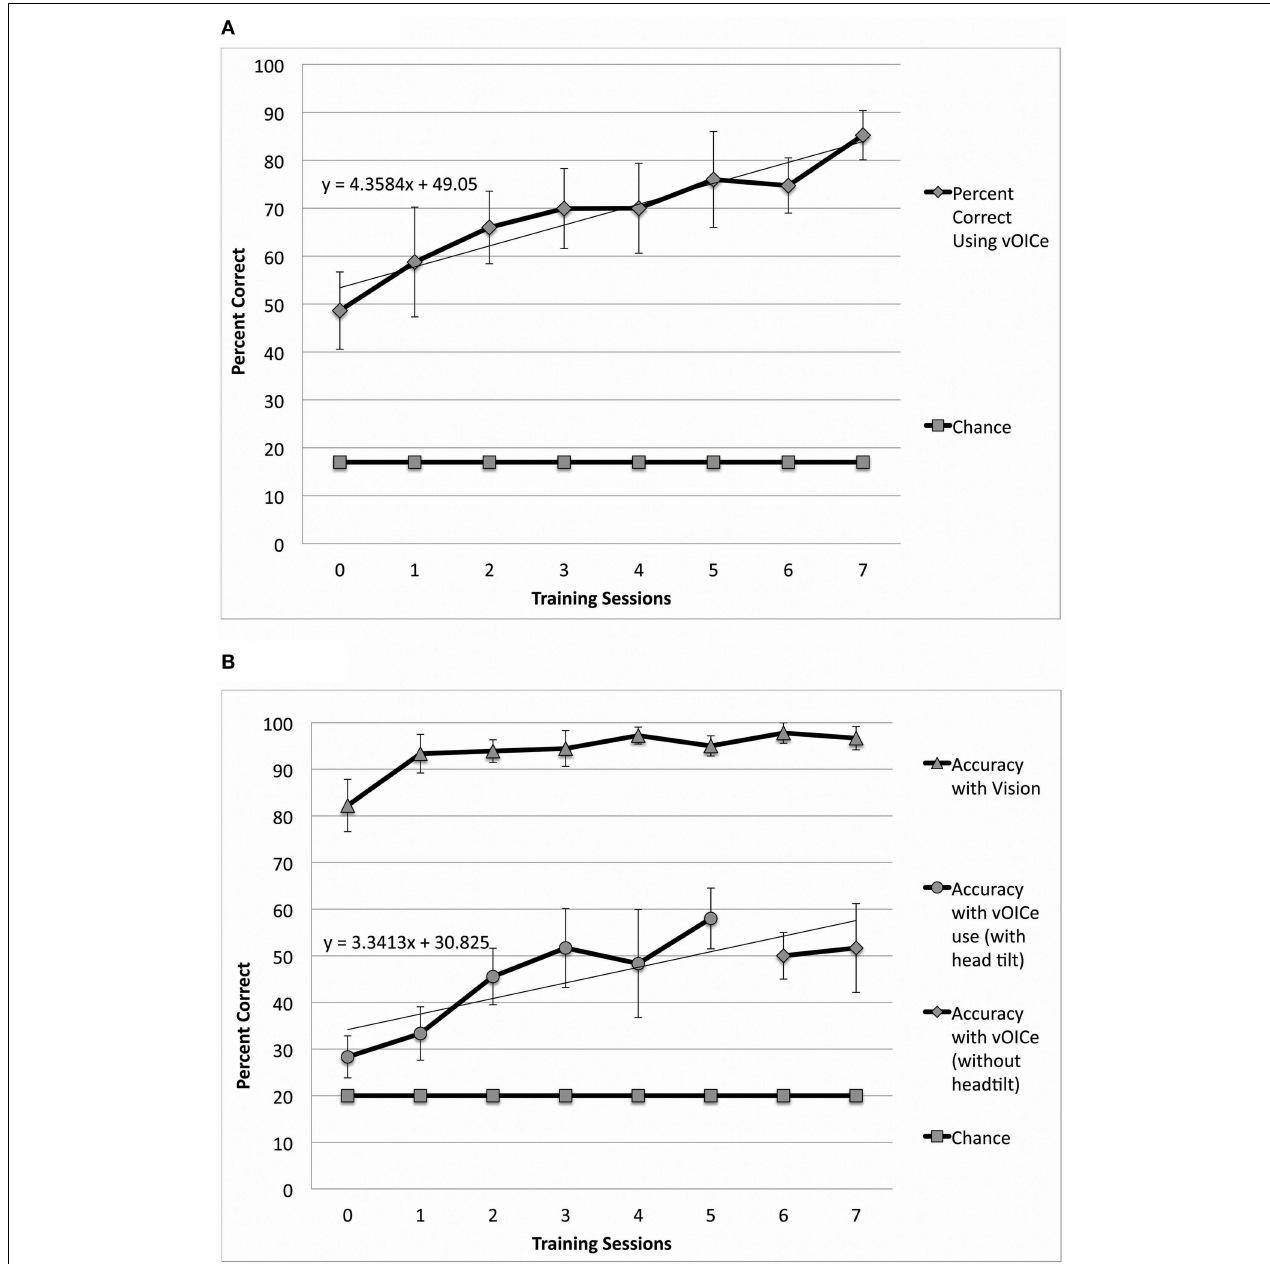
FIGURE 2 | Performance in both constancy tasks by sighted subjects ( N = 9 − 10 ). In (A) the orientation constancy task performance (classification of line orientation angle independent of head tilt) is plotted as a function of the number of training sessions ( N = 10 ). In (B) the length